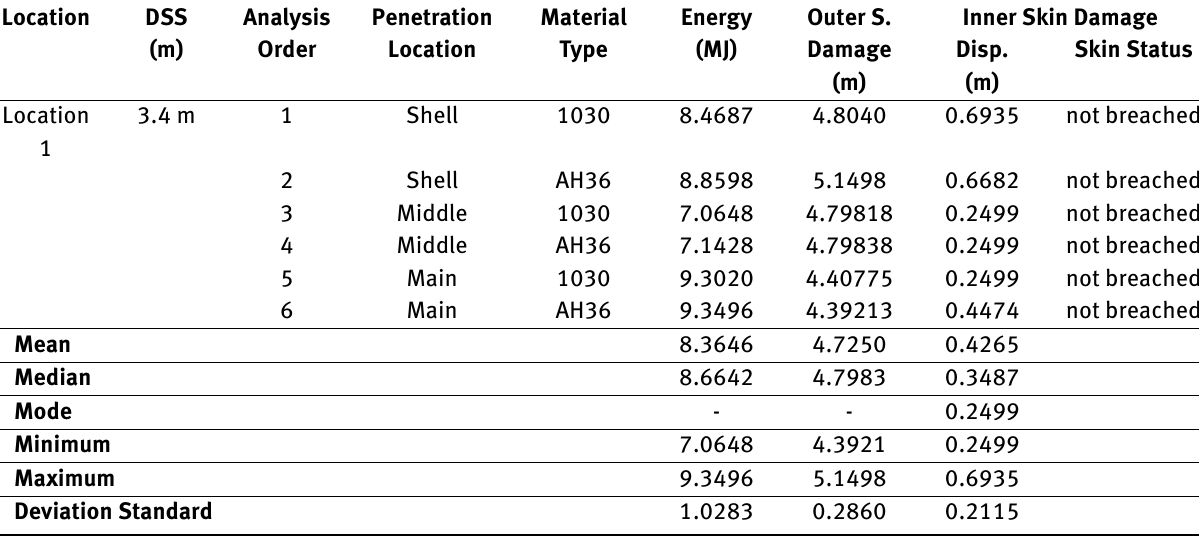
Table A.1: Statistical analysis on Location 1.